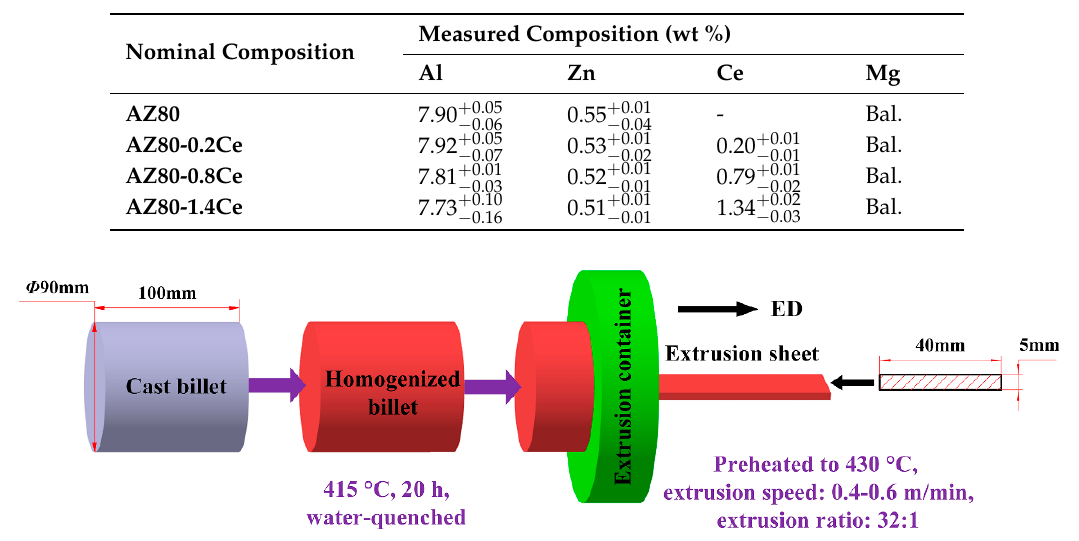
Table 1. The chemical compositions of the measured alloys.